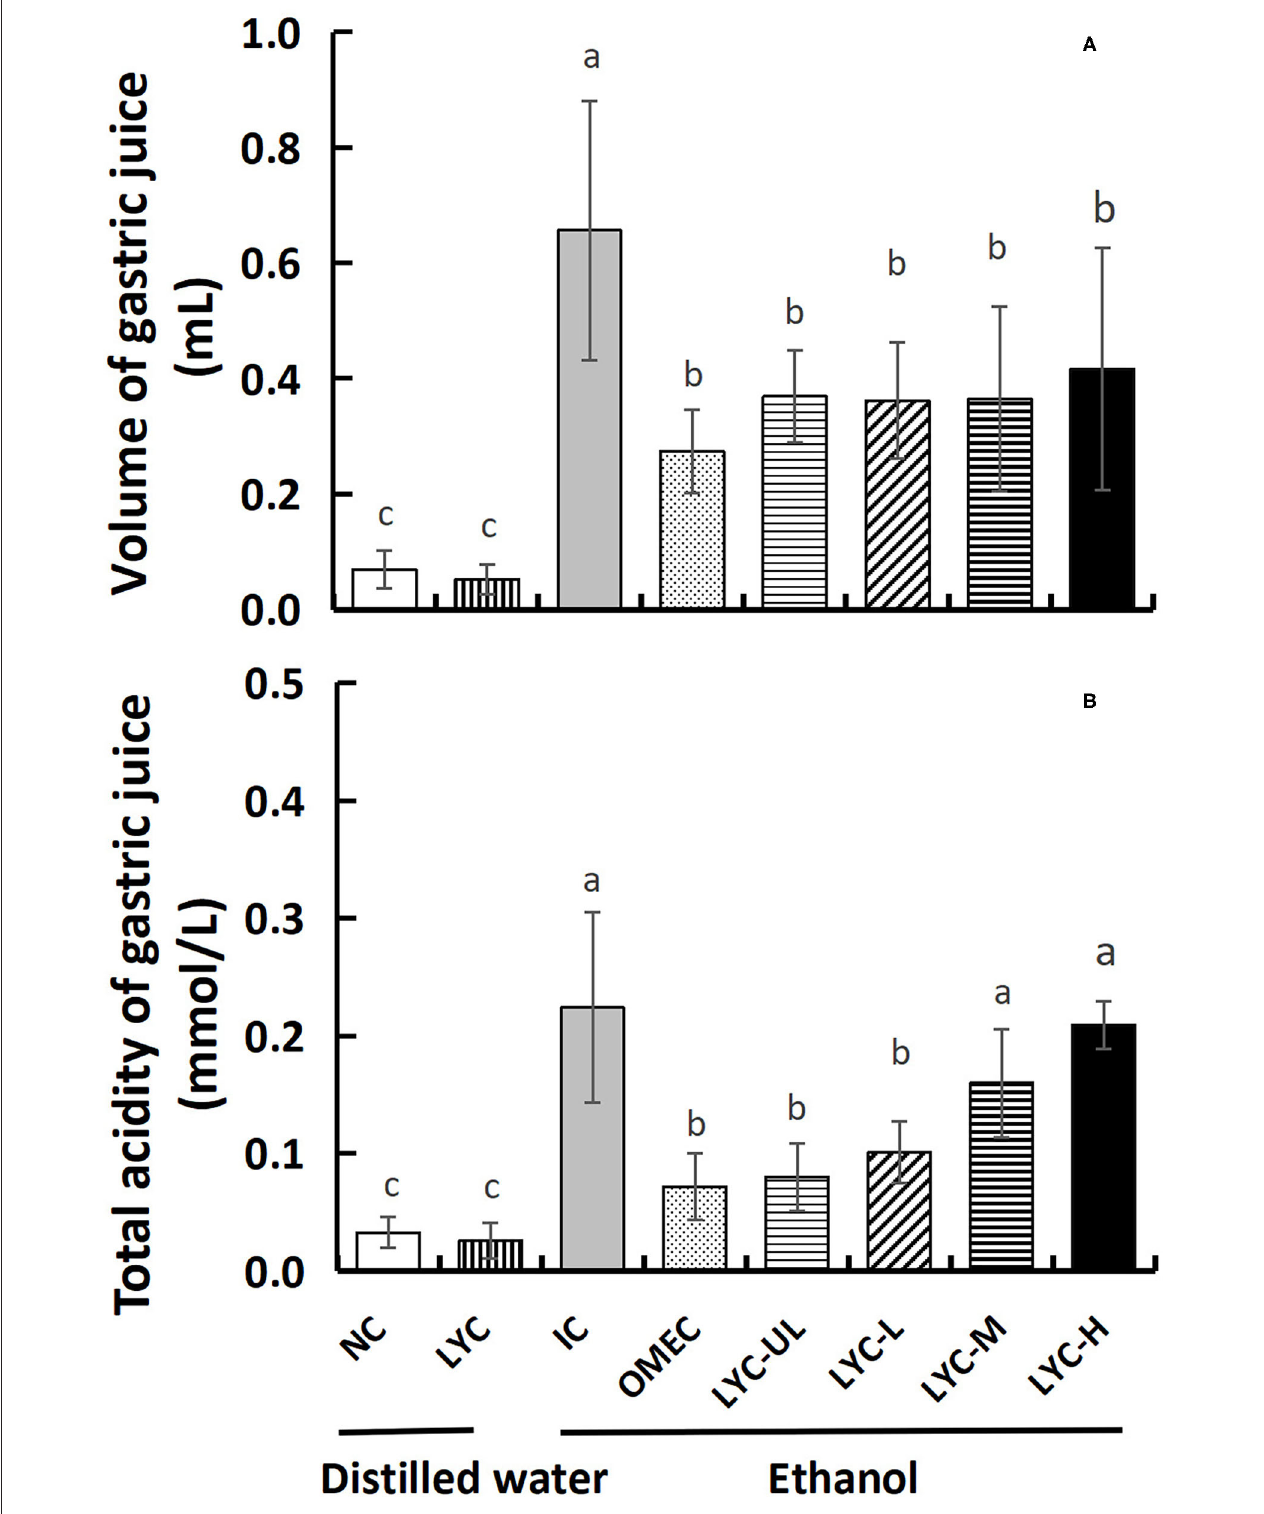
FIGURE 3 | Volume and total acidity of gastric juice. (A) Volume of gastric juice. (B) Total acidity of gastric juice. NC, normal control; LYC, lycopene control group; IC, injury control group; OMEC, omeprazole control group; LYC-UL, ultralow-dose group; LYC-L, lycopene low-dose group; LYC-M, lycopene medium-dose group; LYC-H, lycopene high dose group. NC and LYC groups were perfused with distilled water; IC, OMEC, LYC-UL, LYC-L, LYC-M, and LYC-H groups were perfused with 6.67 ml/kg absolute ethanol. Different letters (a–c) indicate significant differences ( P < 0.05) between different groups.